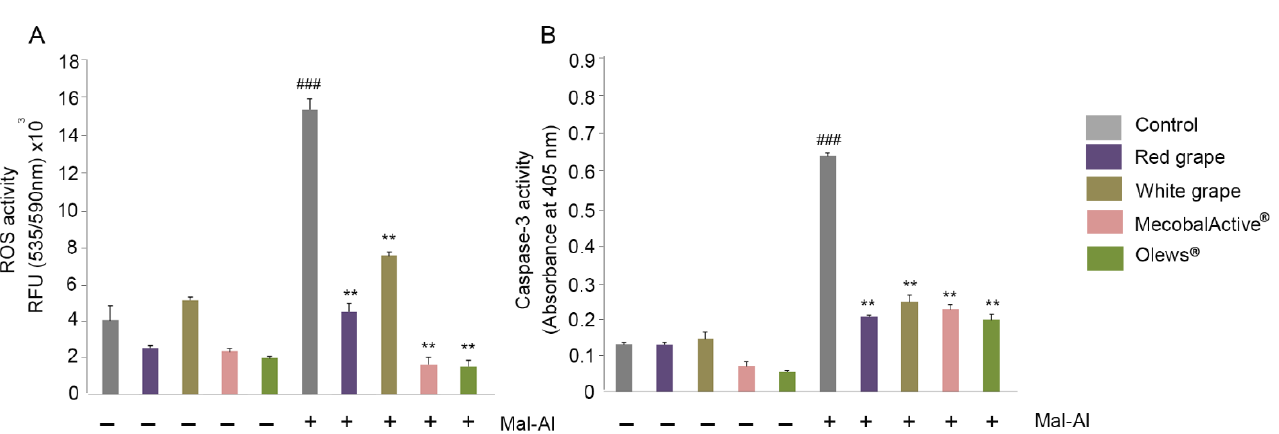
(Figure 3B (cid:48) ,E (cid:48) ,F (cid:48) ). In the case of Cardiose ® , citicoline, and MecobalActive ® , there was